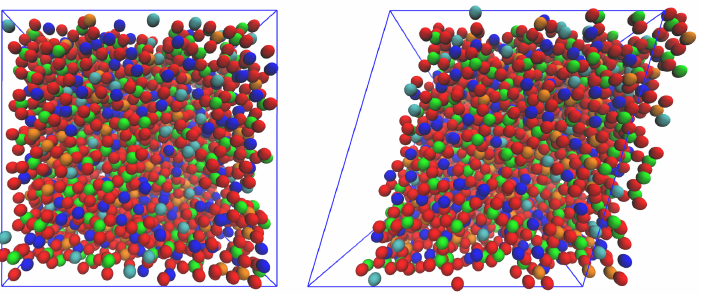
Figure 1. Depiction of the model for Na 2 O –CaO–Al 2 O 3 –SiO 2 system (Na: cyan; Ca: blue; Al: orange; Si: green; O: